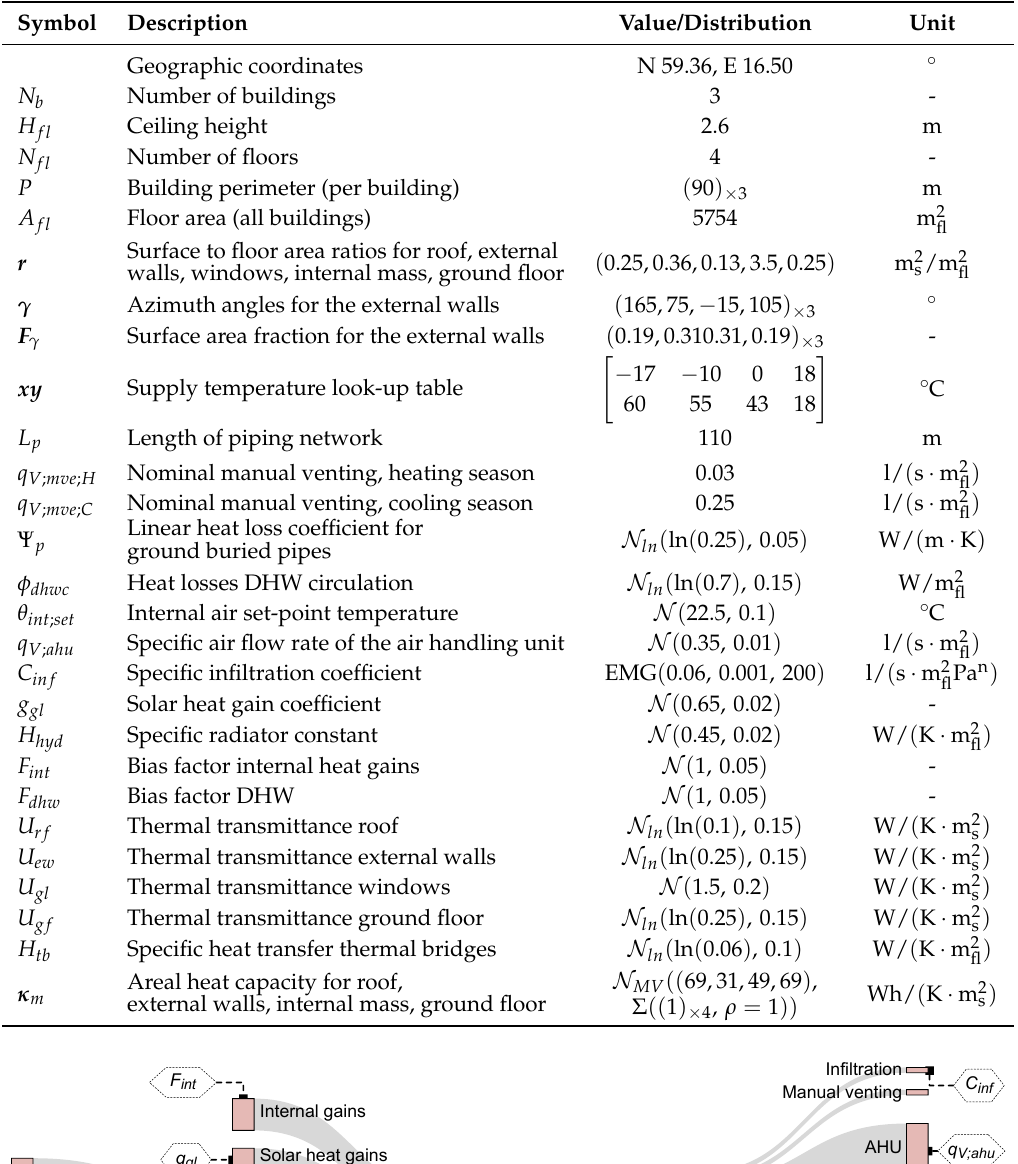
Table 1. Input parameters of the case study: Parameters considered as uncertain are expressed as probability density functions.